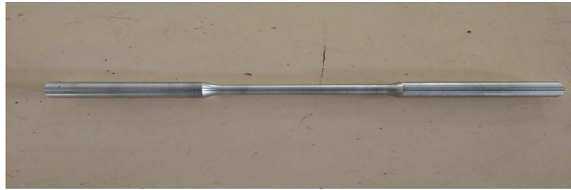
Figure 14: Tensile test specimen.